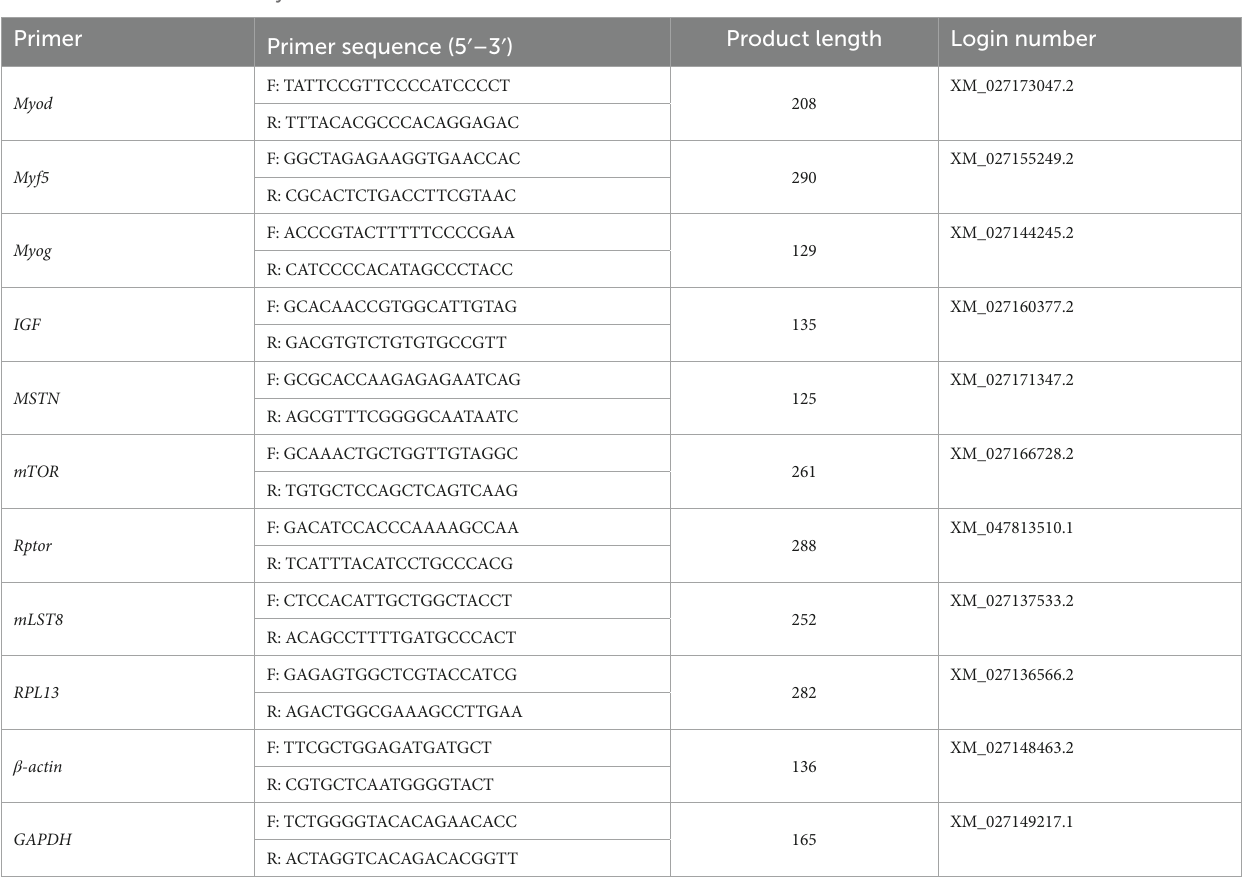
TABLE 2 Primers used in this study. Primer Primer sequence (5